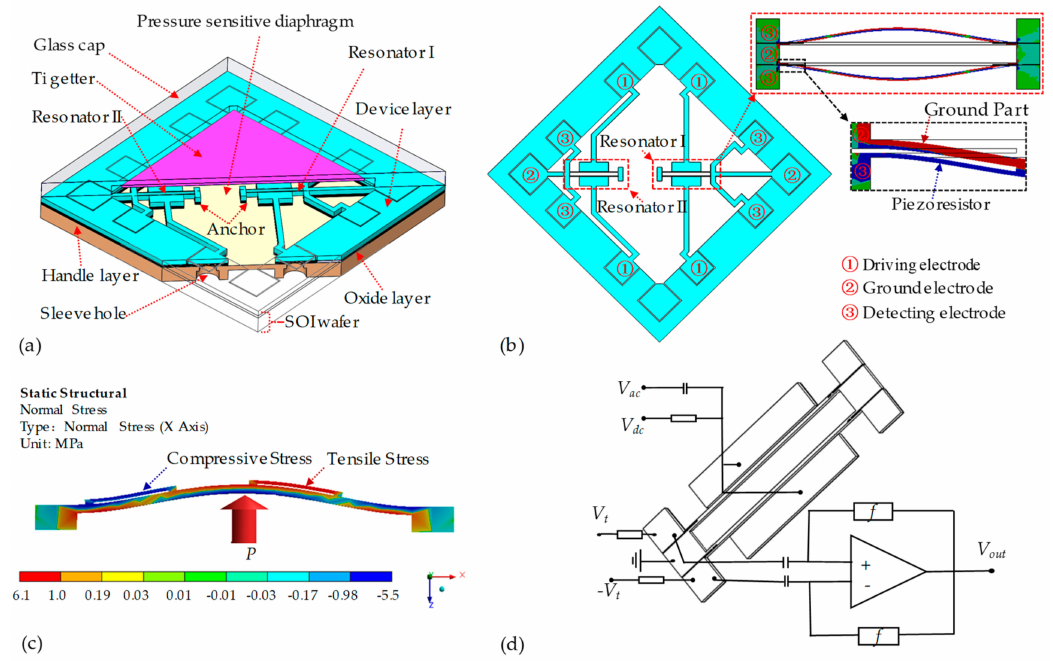
Figure 1. ( a ) Schematic of the proposed resonant pressure micro sensor; ( b ) schematic of the device layer and the resonator of the proposed sensor; ( c ) schematic of axial stresses of the resonators when pressure applied to the pressure sensitive diaphragm; and ( d ) the exciting and detecting circuit of the